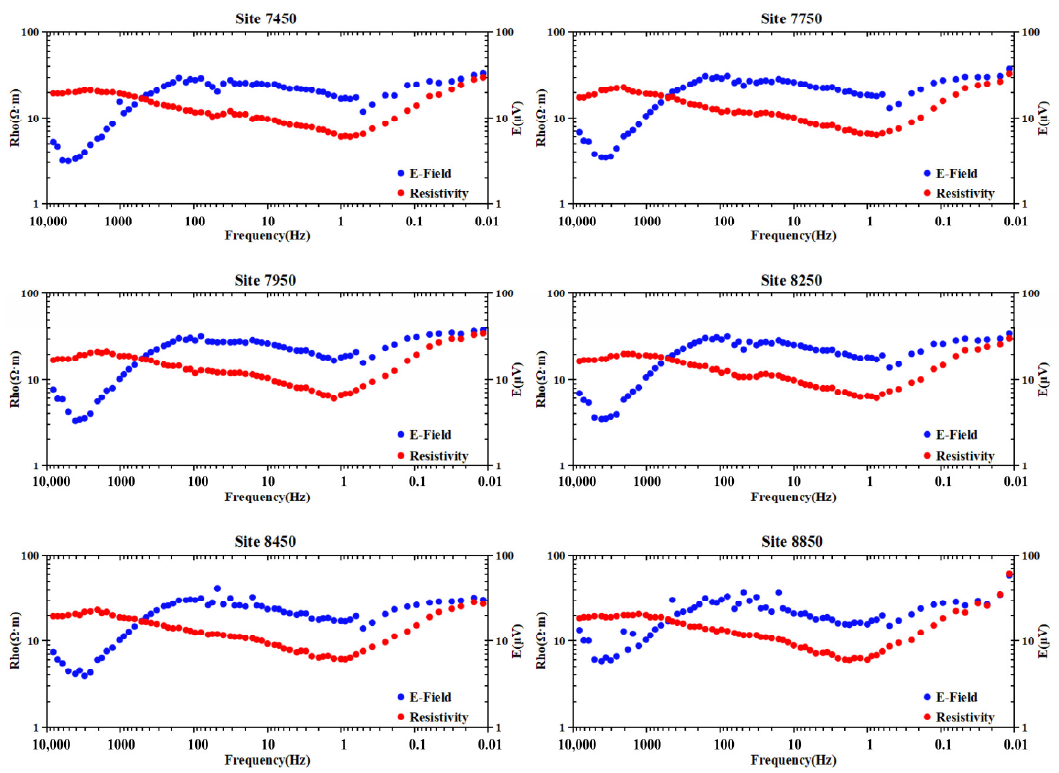
Figure 4. Frequency–electrical field–apparent resistivity curves of typical sites on profile PGY1.